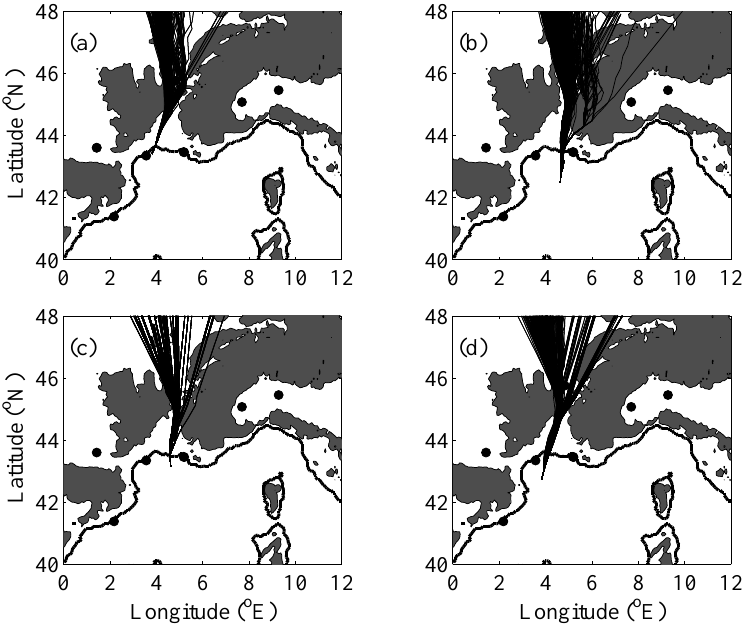
Fig. 13. Back plumes ending at 3.9 ◦ E/43.4 ◦ N (way-point A) (a) , 4.65 ◦ E/42.5 ◦ N (way-point F) (b) , 4.7 ◦ E/43.2 ◦ N (way-point C) (c) and 3.88 ◦ E/42.75 ◦ N (way-point E) (d) . The back plumes ending points correspond to the starting and ending points of the ARAT legs and the aerosol plumes detected by the lidar LEANDRE-2 on board the ARAT. The altitude of the ending points is 50m. The ending times of the back plumes are 16:00 and 17:00UTC for the first and second rows, respectively. Filled black dots indicate the cities of Barcelona, Toulouse, Montpellier, Marseille/Fos-Berre, Lyon, Torino and Milano.